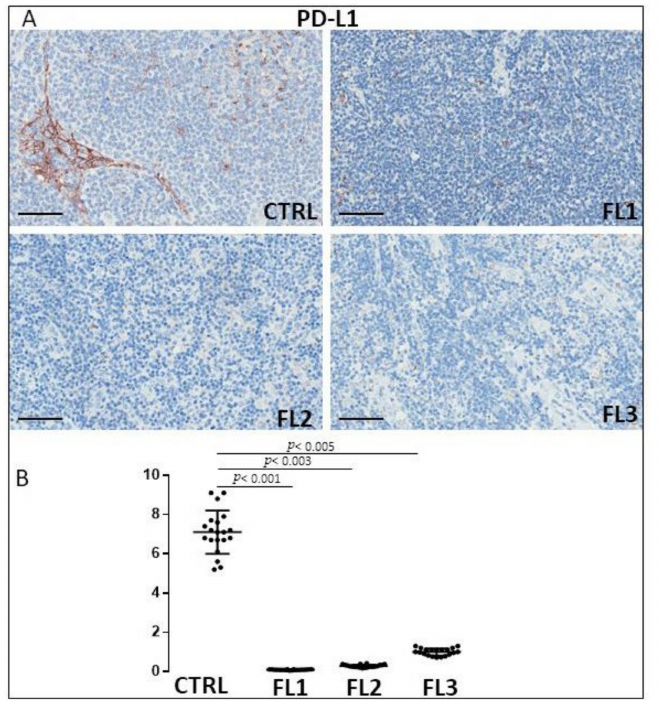
Figure 7. Immunohistochemical staining for PDL-1 in FL grade1 (FL1), FL grade2 (FL2), and FL grade 3 (FL3) and control samples (CTRL). Scale bar: 60 µ m ( A ). Morphometric analysis indicates the percentage of PDL-1 positivity in FL and CTRL samples ( B ).